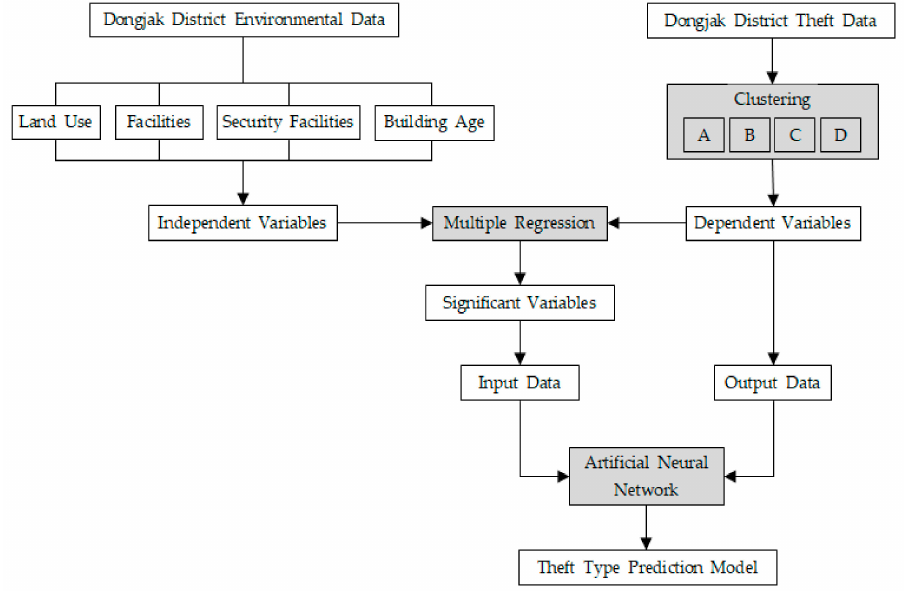
Figure 2. Research